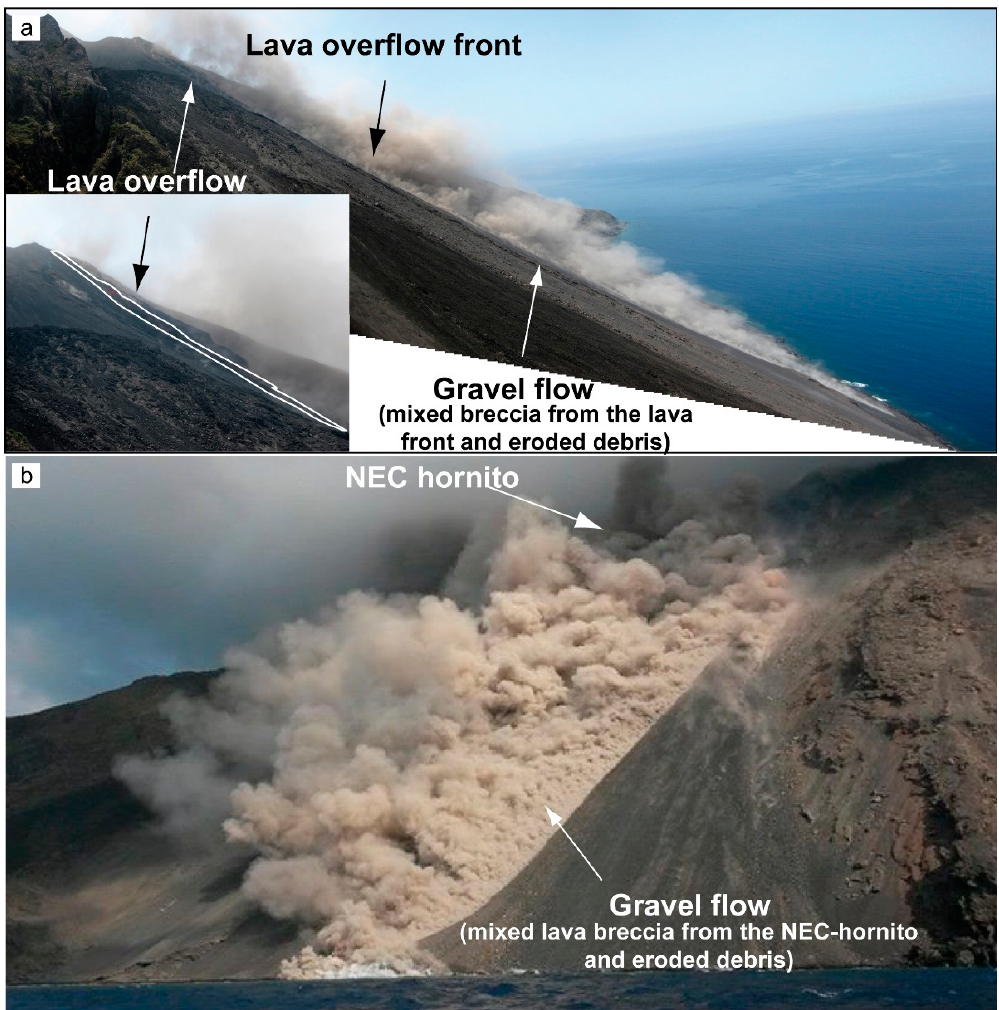
Figure 2. ( a ) Gravel flow associated with the 7 July 2014 overflow. The landslide is composed by mixed breccia from the overflow front and the (mainly fine-grained) debris eroded along the Sciara del Fuoco (photo taken by the Università degli Studi di Firenze personnel during field survey). ( b ) Landslides associated with the collapse of the NEC-hornito, occurred on 6 August 2014 (photo taken by UNIFI personnel during boat survey).